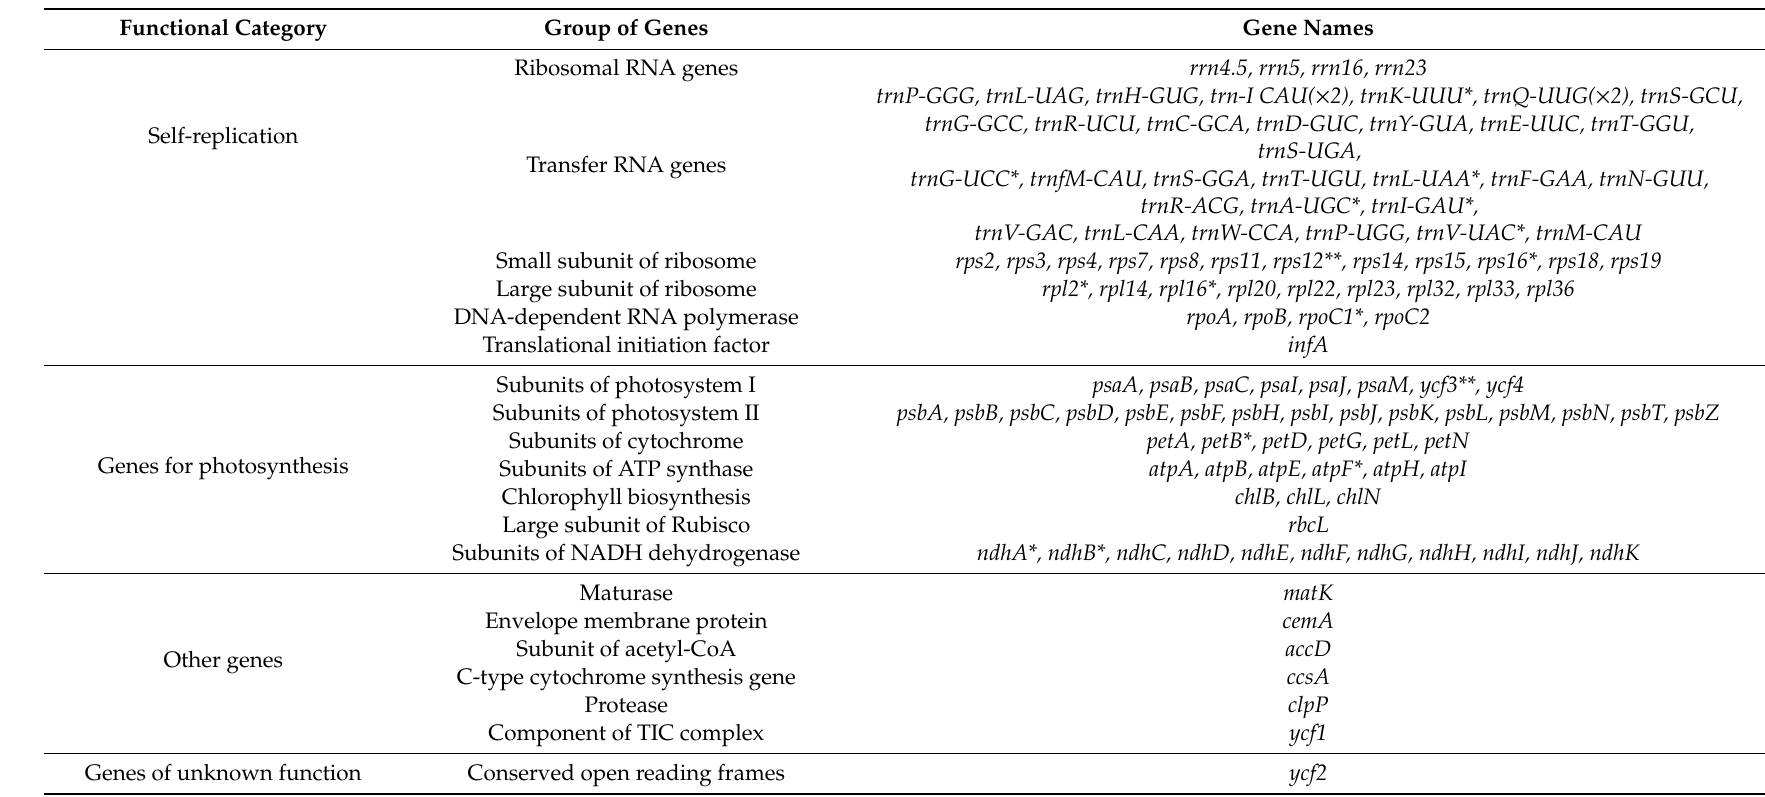
Table 1. List of genes found in the F. hodginsii cp